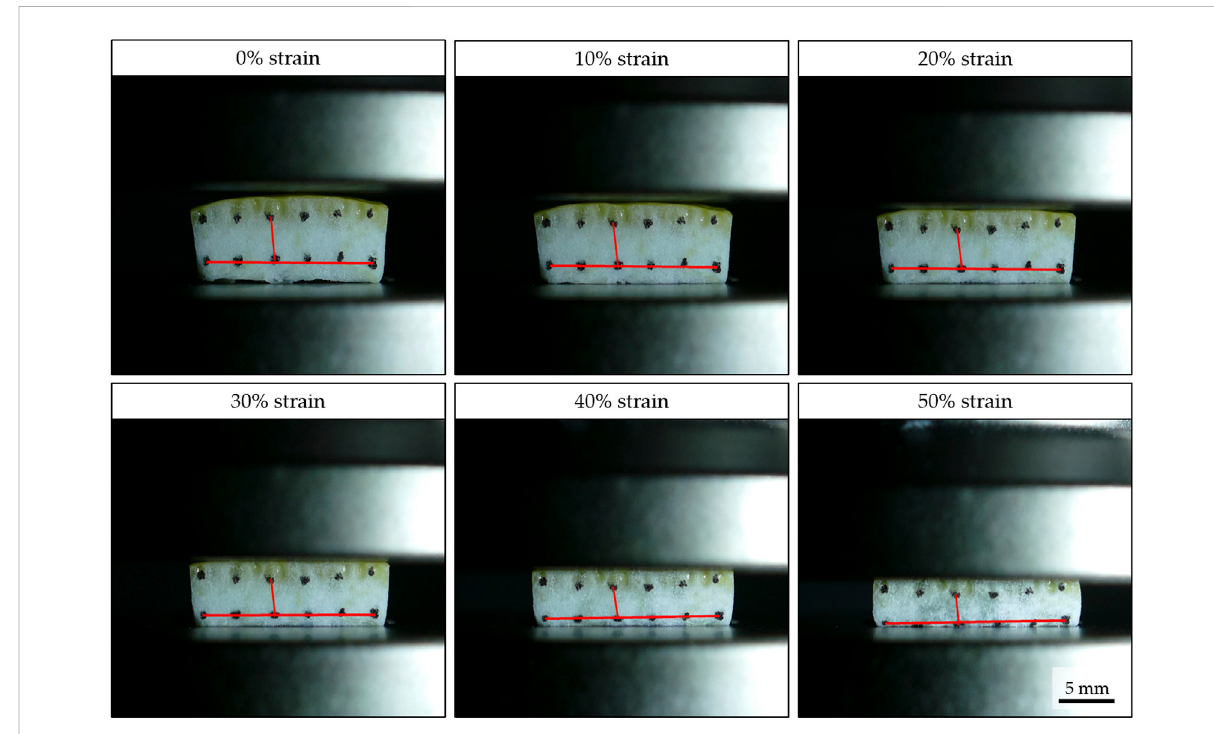
FIGURE 6 Characteristic deformation images of the peel of lemon ( C. x limon ) at increasing strain. Sample height at a strain level of 0% is 5.69